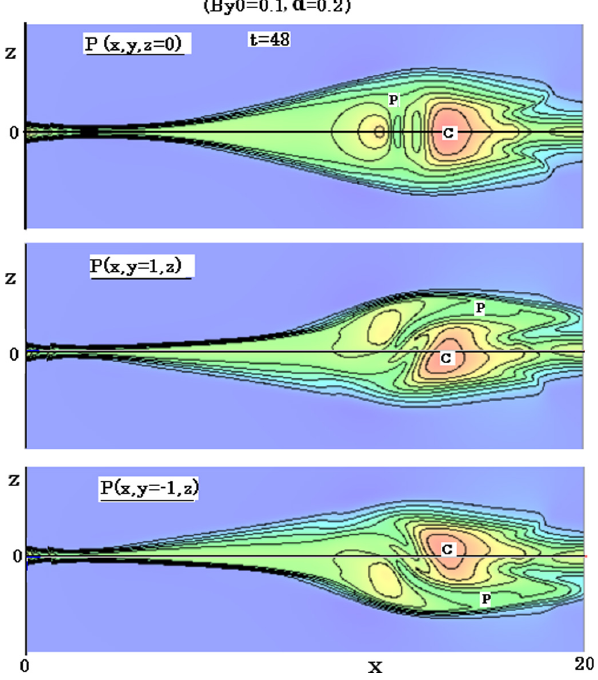
Fig. 13. Plasma pressure distributions (contour interval of 0.15) at t = 48 in the y = 0, y = 1 and y = − 1 planes for the case of B y0 = 0 . 1 and α = 0 . 2, where the regions P and C are indicated.